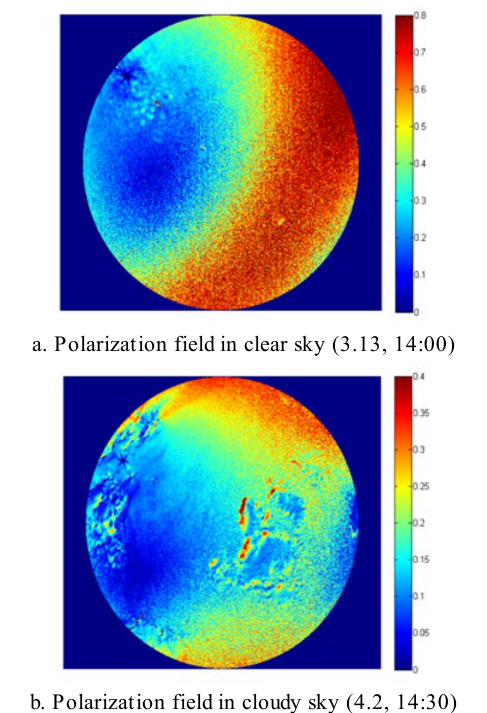
Figure 4. Skylight polarization in different weather